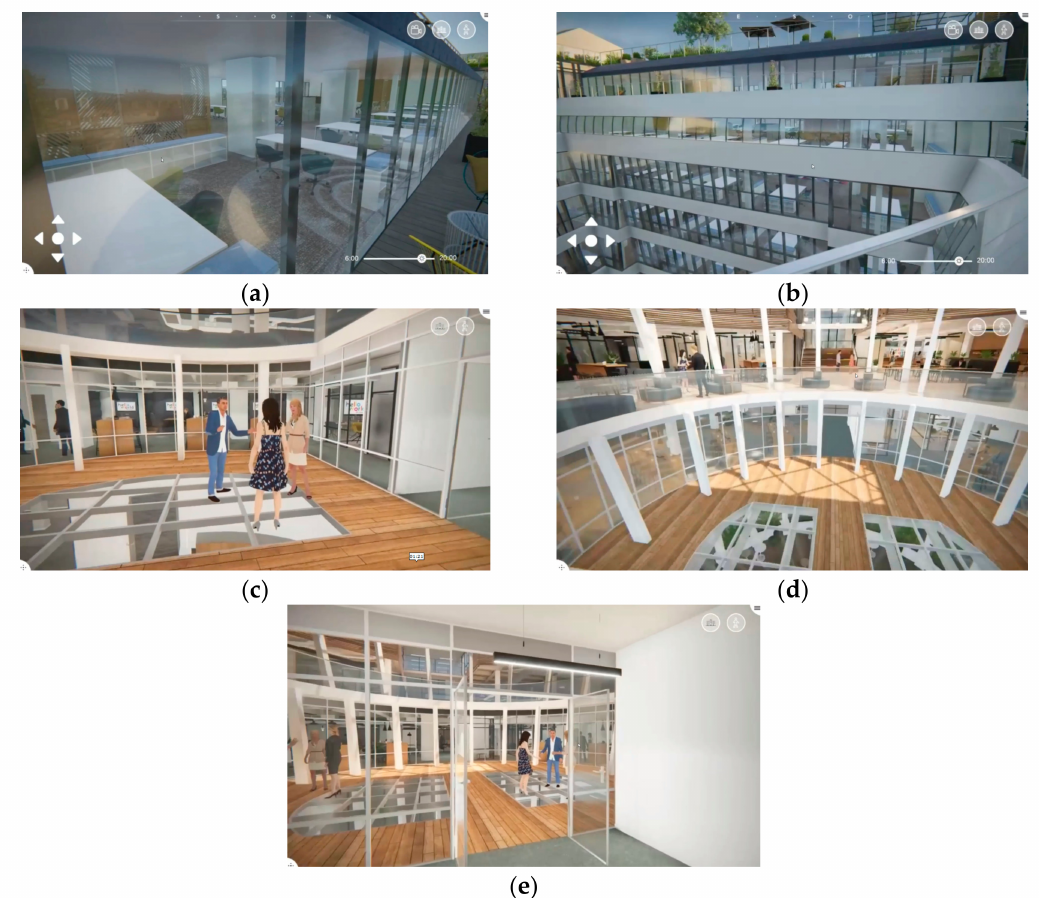
Figure 20. Selection of frames from the pre-recorded VR video clip with marked POS or NEG reactions (adapted from [45], © Generali Real Estate French Branch): ( a )–( b ) facade panels; ( c ) floor; ( d ) indoor balustrades; ( e ) indoor partition